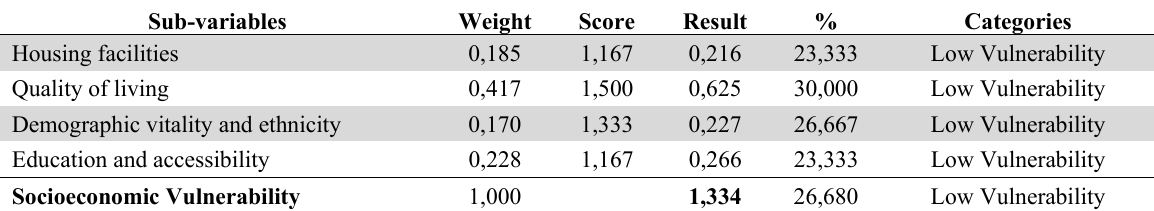
Vulnerability evaluation scores for power relationship of TNI-Polri in Socio-economic variable.